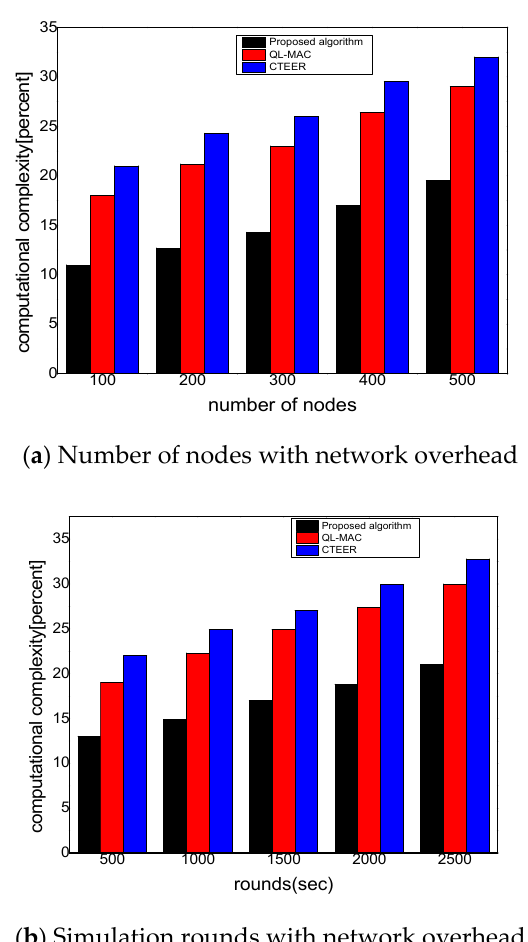
Figure 10. The performance evaluation of the proposed algorithm compared to QL-MAC and CTEER for computational complexity.